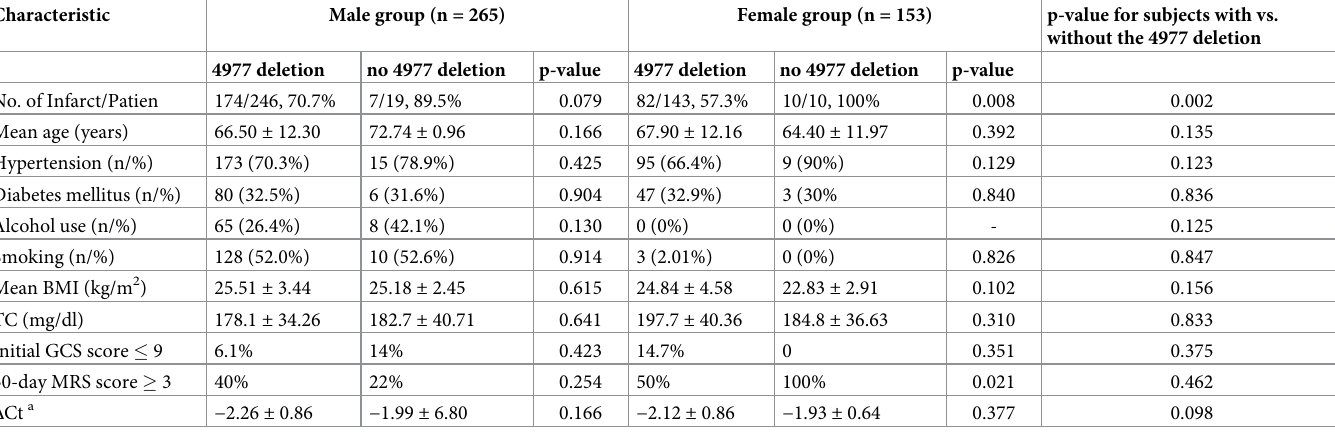
Table 4. Comparison of patients with and without the 4977